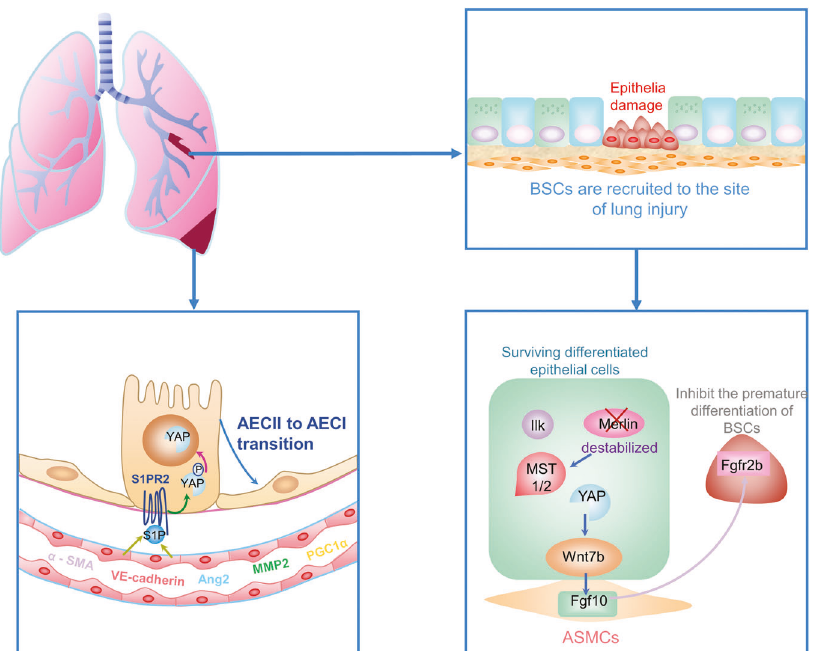
Fig. 2 The role of hippo signaling pathway in ALI. During epithelial damage, BSCs are activated and recruited to the site of lung injury. Surviving differentiated epithelial cells recruit integrin-linked kinases to adhesion sites with the injury, which result in degradation of Merlin, downregulation of the hippo pathway, and the secretion of Wnt7b. The Wnt7b induces ASMCs to release Fgf10, which binds to Fgfr2b on BSCs to mobilize and amplify stem/progenitor cell populations by inhibiting premature differentiation of BSCs, thereby promoting lung regeneration. In addition, S1P released by LMVECs promotes the proliferation and differentiation of AECIIs through the S1P-S1PR2-YAP signaling axis, thus regulating alveolar epithelial repair. Meanwhile, YAP promotes the germination and remodeling of neovascules through various angiogenesis factors such as Ang2, MMP2, VE-cadherin, α ‐ SMA, and PGC1 α . Note: ALI acute lung injury; BSCs basal stem/progenitor cells, ASMCs airway smooth muscle cells, Fgf10 fi broblast growth factor 10, Fgfr2b fi broblast growth factor receptor 2, S1P sphingosine-1- phosphate, LMVECs lung microvascular endothelial cells, AECIIs type II alveolar epithelial cells, AECI type I alveolar epithelial cells, YAP Yes- associated protein, Ang2 Angiopoietin-2, MMP2 matrix metallopeptidase 2, α ‐ SMA α -smooth muscle actin, PGC1 α peroxisome proliferator- activated receptor γ coactivator 1 α